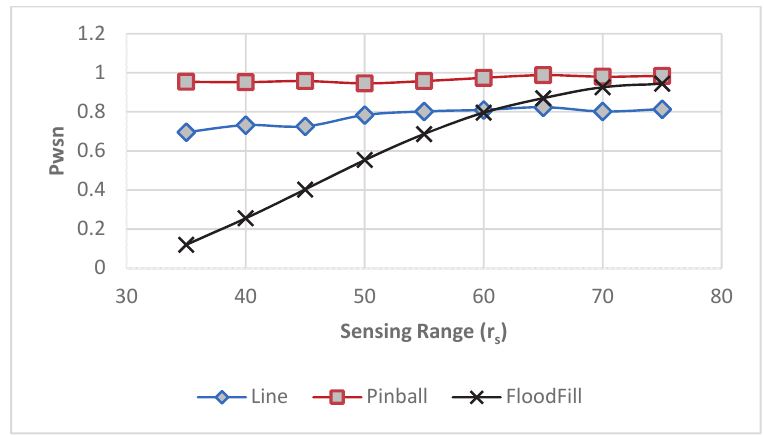
Figure 9. The WSN win probability ( P wsn ) of an intruder that adopts the linear, pinball and flood-fill algorithms in a WSN with varying sensing range r s . (cid:3)